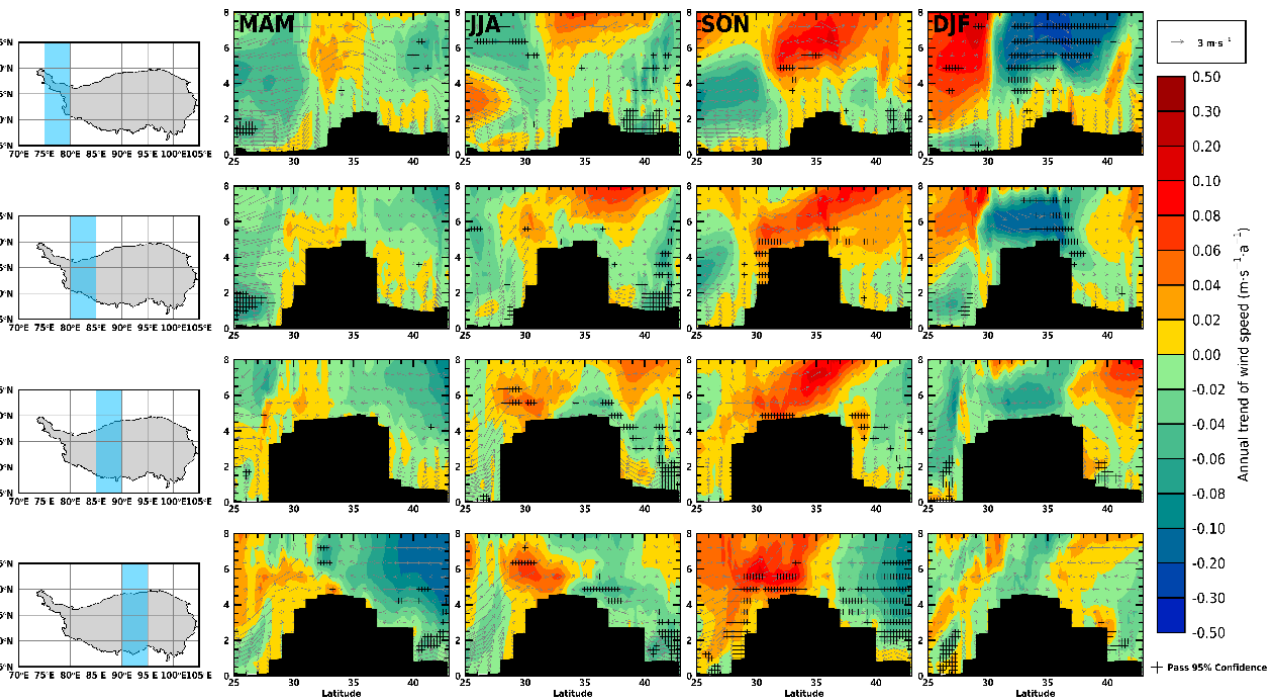
Figure 6. Distributions of the linear annual trends of the seasonal dust extinction coefficient ( 𝜎 (cid:3005) ) at 532 nm on four longitudinal transects during 2007 − 2020. The black point represents the linear trend passing the significance test at the level of 0.05.